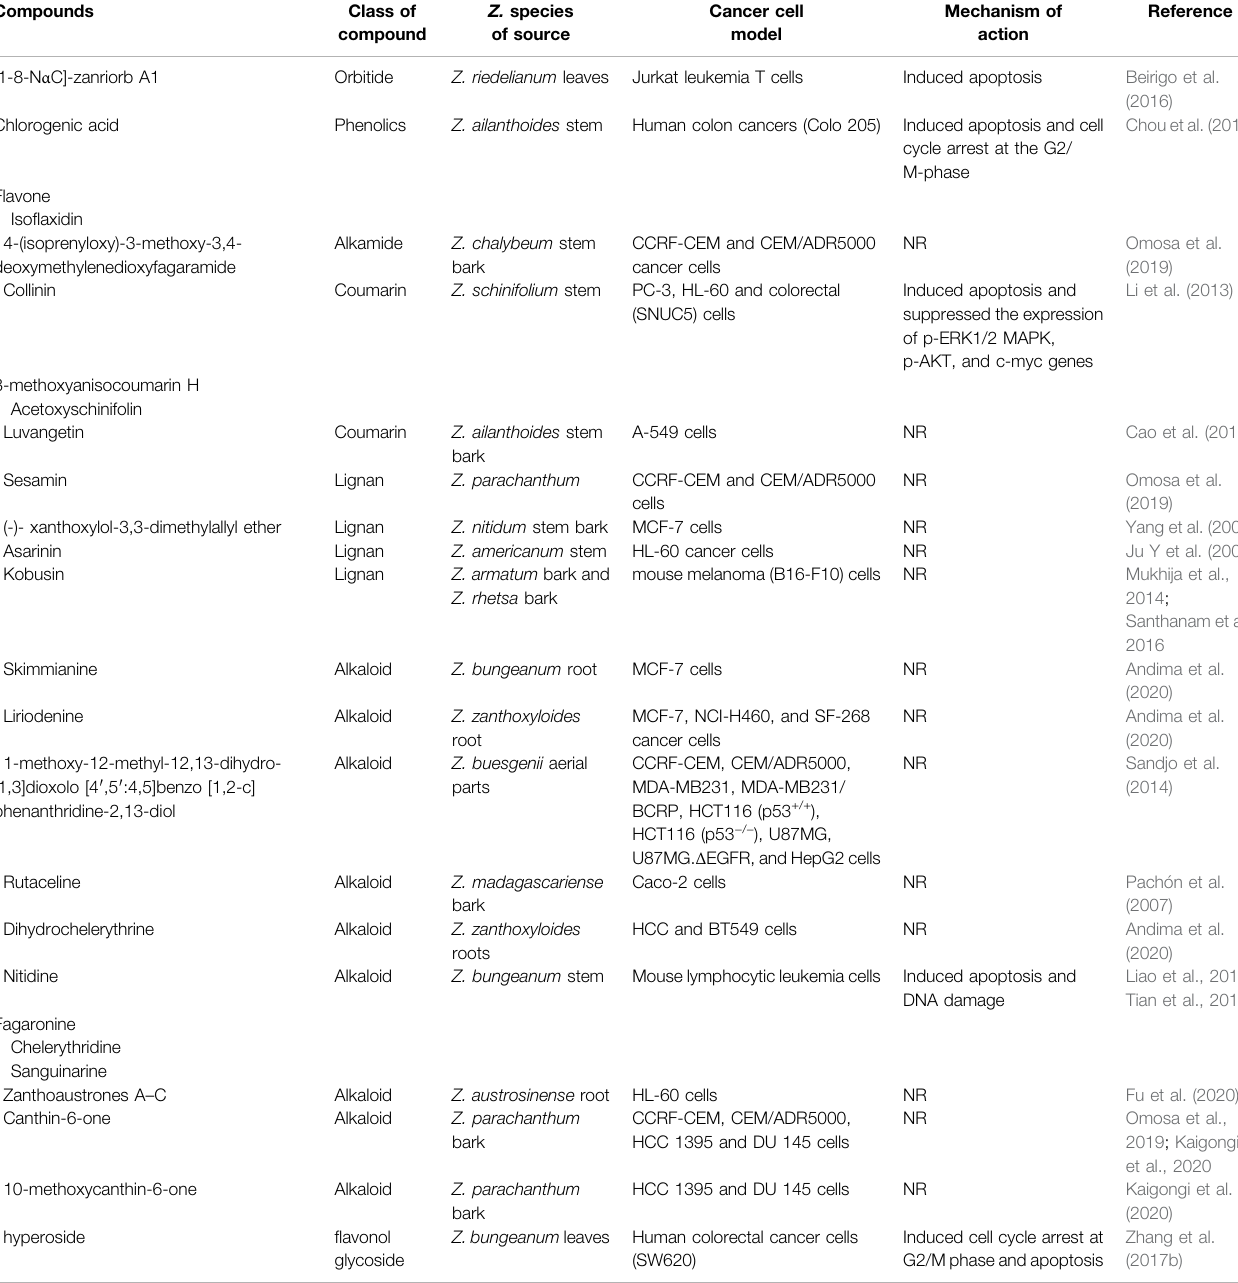
TABLE 2 | Chemical compounds isolated from Zanthoxylum species with in vitro anticancer properties.